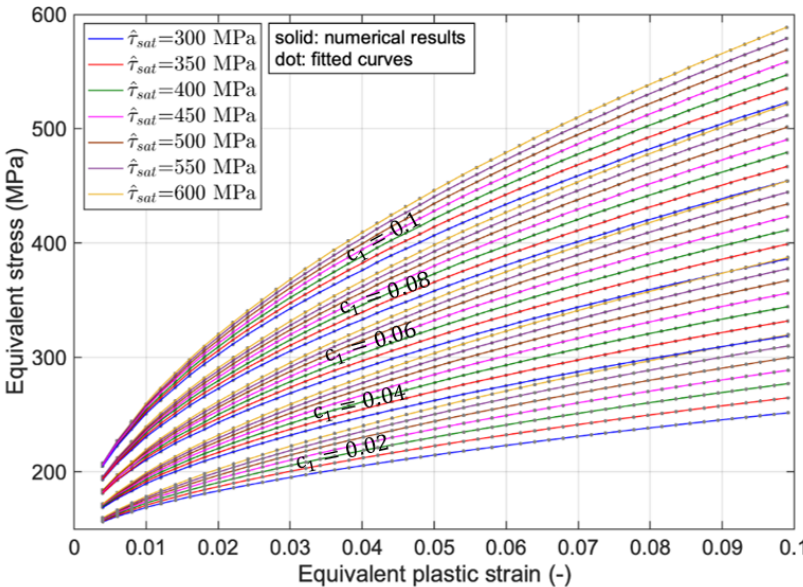
Figure 13. Comparison between numerical results and fitted curves with change in both ˆ τ sat and c 1